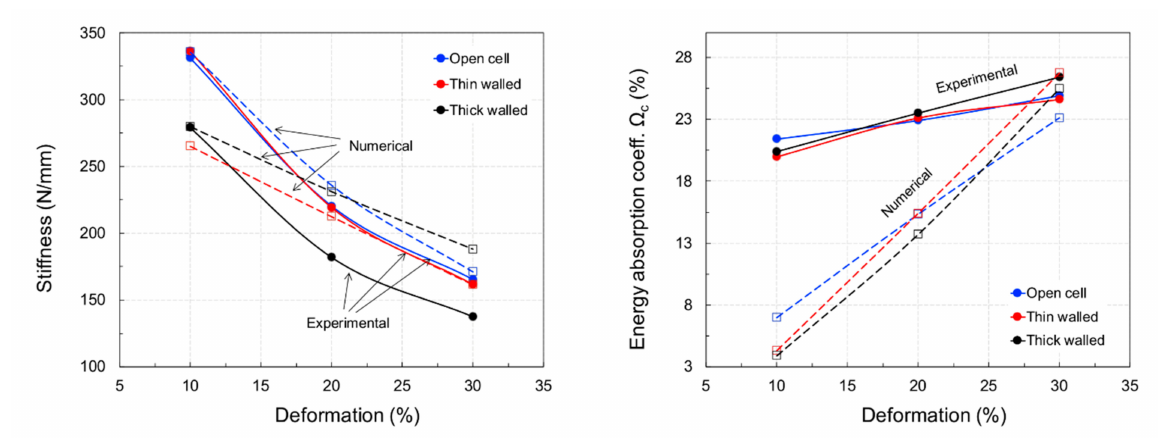
Figure 12. Experimental and numerical